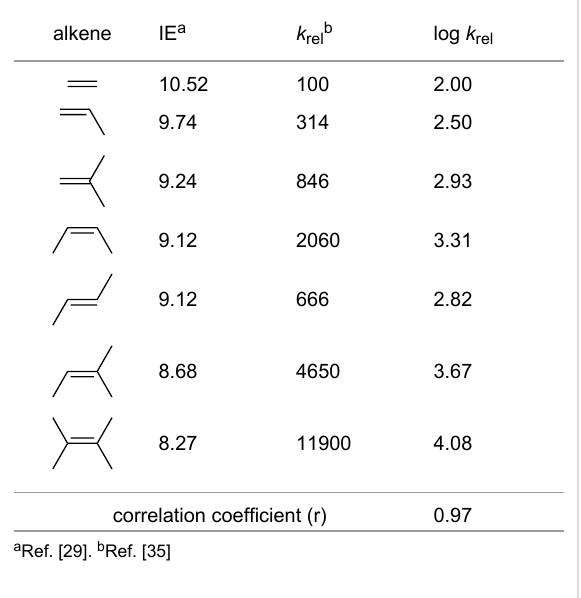
Table 6: Alkene IEs (eV), relative rates ( k rel ), and log k rel values of PhSCl addition to olefins.